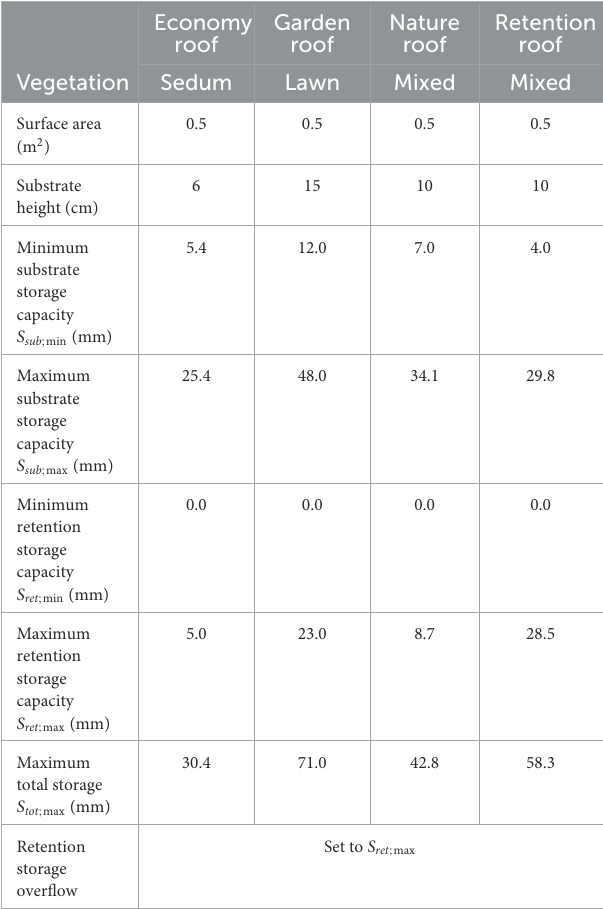
TABLE 1 Green roof parameters (modified after Gößner et al., 2021).